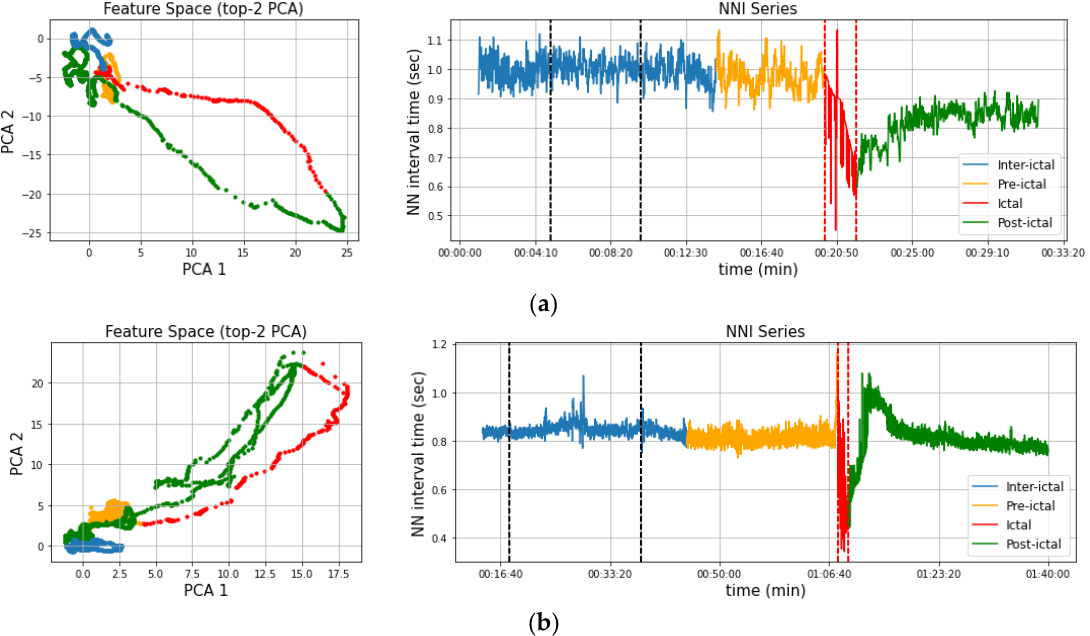
Figure 4. Examples of NN series and the corresponding top-2 PCA features that were extracted from them; seasonality and subfigures correspond to cases sz04-1 ( a ) and sz07-1 ( b ). The black dashed lines correspond to the reference interval whereas the red lines correspond to the seizure event.